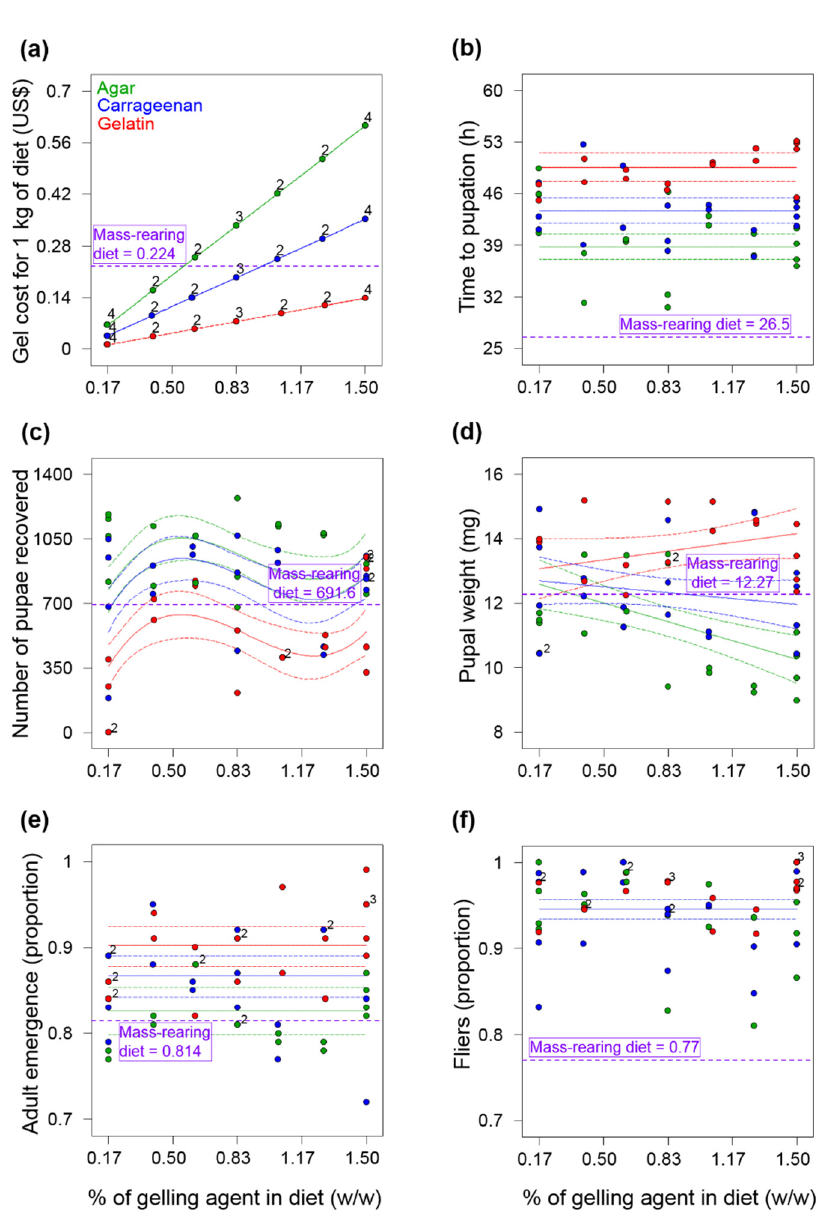
Figure 2. Polynomial models fitted to data on ( a ) gels costs, ( b ) time to pupation, ( c ) number of larvae recovered, ( d ) pupal weight, ( e ) adult emergence and ( f ) flight ability (fliers) of Anastrepha ludens as a function of the type of gelling agent (agar, carrageenan and gelatin) and its percentage in a larval gel diet. The circles indicate data points and the solid line the model fitted to data with 95% CI. The horizontal purple dotted line in each figure panel indicates the mean value (n = 5) observed in the mass-rearing diet, which in the case of panel (a) indicates the cost of the amount of corncob powder in 1 kg of diet.